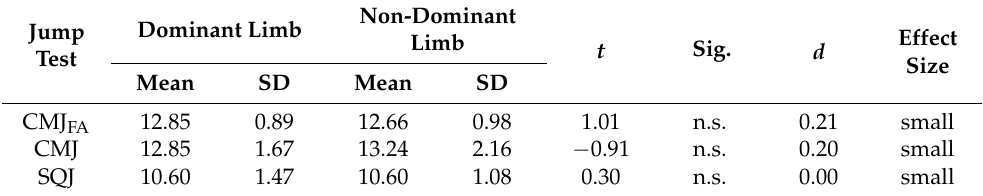
Table 2. Comparison of VGRF among the dominant and non-dominant limbs (N.kg − 1 ).